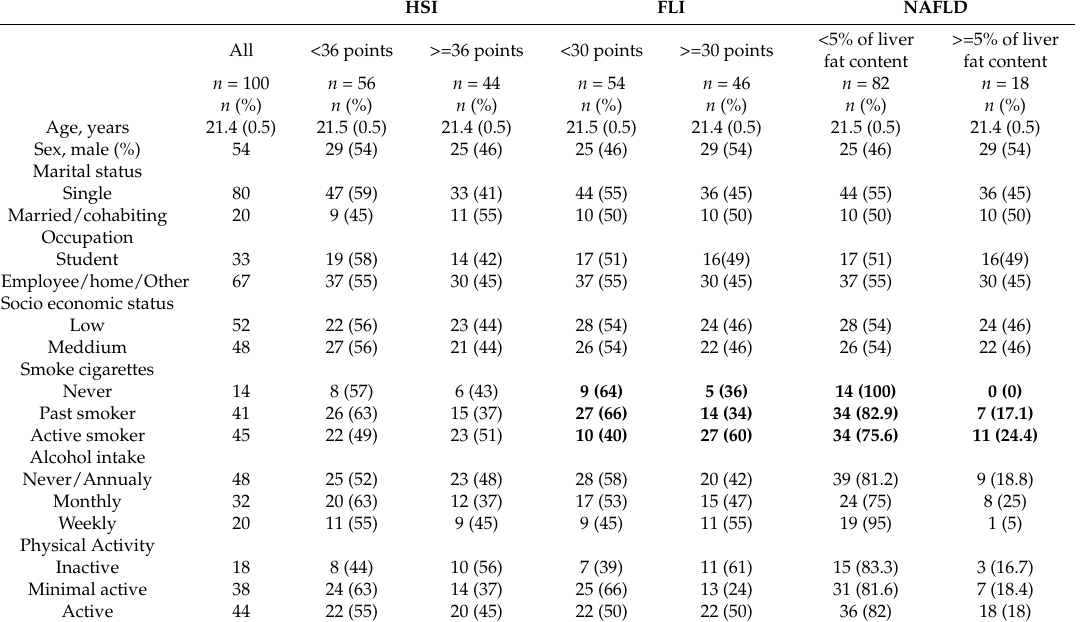
Table 1. Sociodemographic and lifestyle characteristics of the participants in the entire sample and according to the Indices classification and the diagnosed of non-alcoholic fatty liver disease (NAFLD).